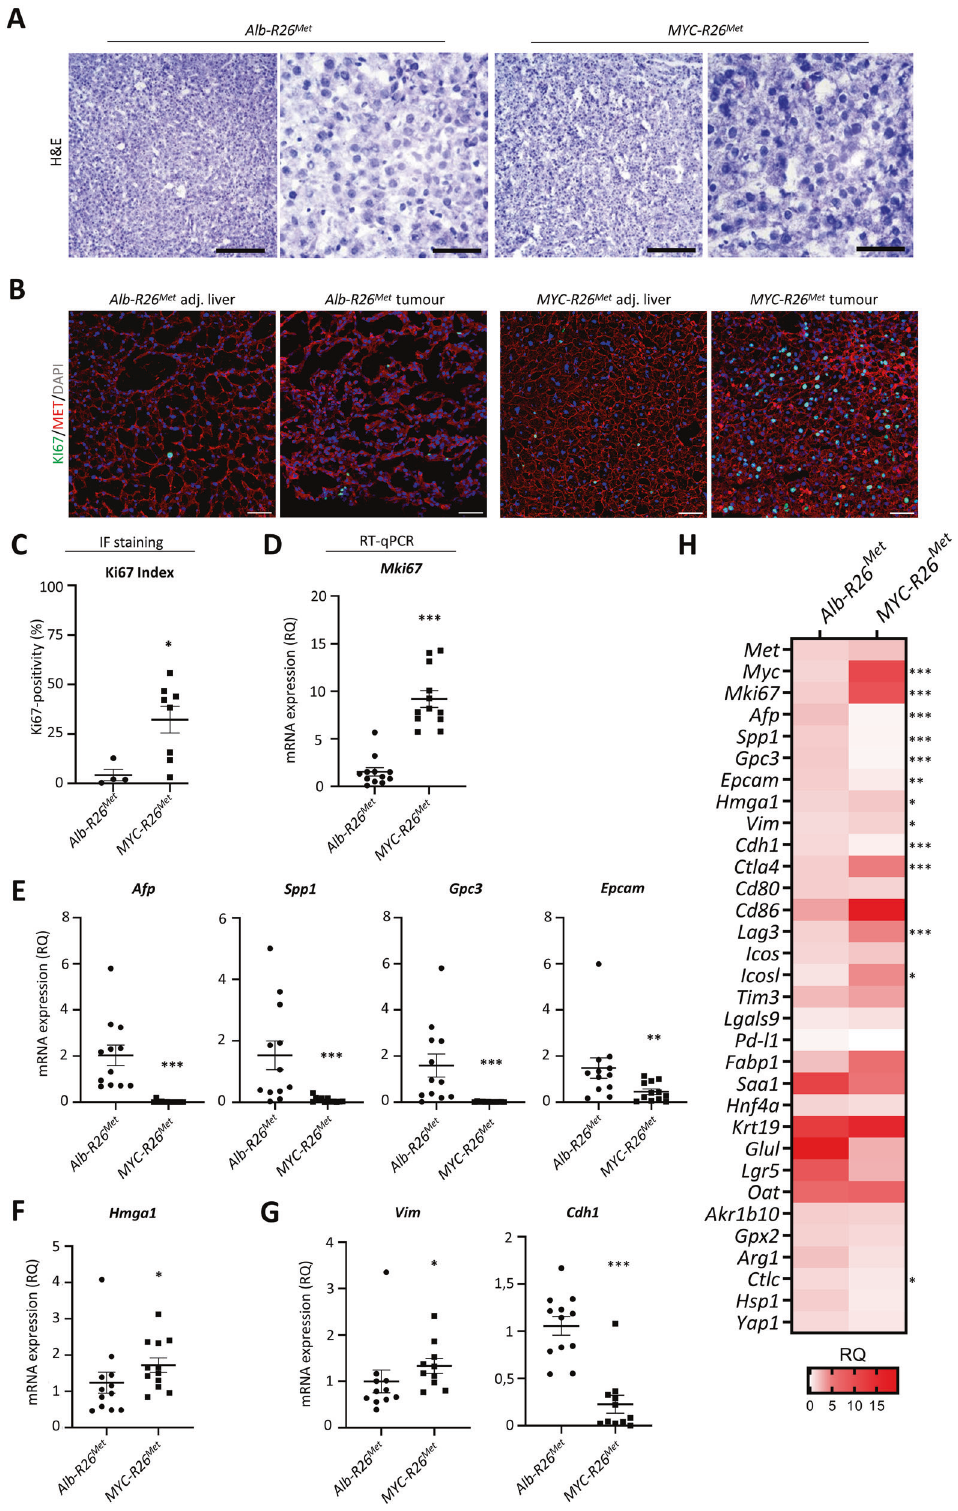
Fig. 3 Hepatocellular characteristics of Myc-R26 Met and Alb-R26 Met tumours. A Representative haematoxylin and eosin staining of frozen, fi xed Alb-R26 Met and Myc-R26 Met tumours and adjacent livers. B , C Representative images ( B ) and graph with quanti fi cations ( C ) of Ki67 immuno fl uorescence staining of Alb-R26 Met and Myc-R26 Met tumour sections (scale bar: 50 µm). D – G mRNA expression levels by RT-qPCR of the proliferation marker Mki67 ( D ), of HCC markers Afp , Spp1 , Gpc3 , and Epcam ( E ), of the non-histone chromatin protein Hmga 1 ( F ), and of mesenchymal Vim and epithelial Cdh1 markers ( G ) in Myc-R26 Met versus Alb-R26 Met tumours. H Heatmap reporting the RQ differential expression of all genes evaluated by RT-qPCR in this study. Values were normalised with the Gapdh housekeeping gene and expressed as RQ, all values relative to Alb-R26 Met tumours. Statistical analyses were performed by Mann – Whitney. * p ≤ 0.05; ** p ≤ 0.01; *** p ≤ 0.001.